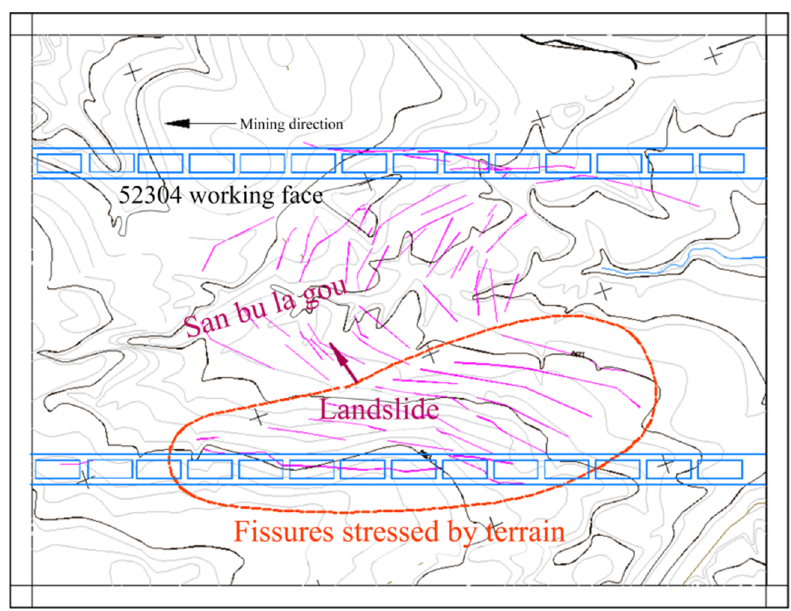
Figure 12. Mining ground fissures under valley topography.